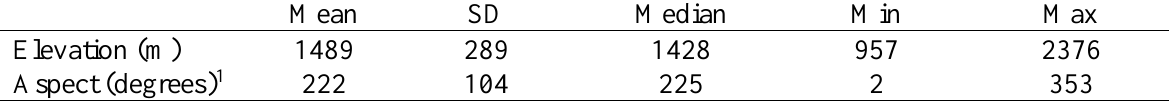
1 Mean vector ( u ), circular standard deviation, and median calculated using circular statistics. Min and Max are linear